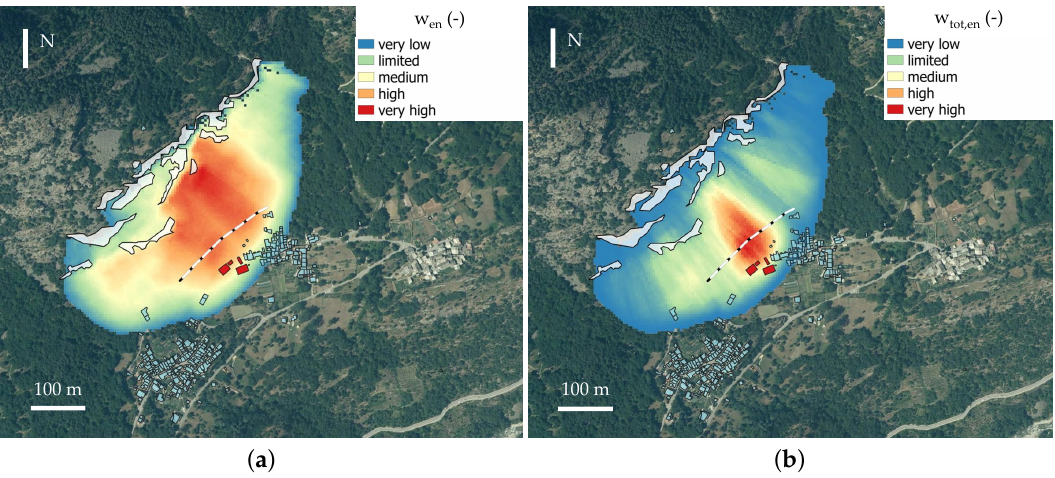
Figure 8. Weighted energy files provided by QPROTO plugin: ( a ) The w_en file provides a qualitative representation of the w en parameter over the estimated invasion zone. The result shows the maximum products between I D and the kinetic energy in each cell; ( b ) the w_tot_en gives the same areas highlighted in the maps of Figure 7a,b